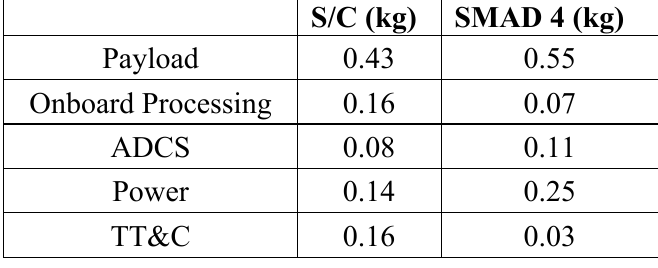
Table 7. Projected Spacecraft Subsystem Mass and comparison to SMAD 4 Values